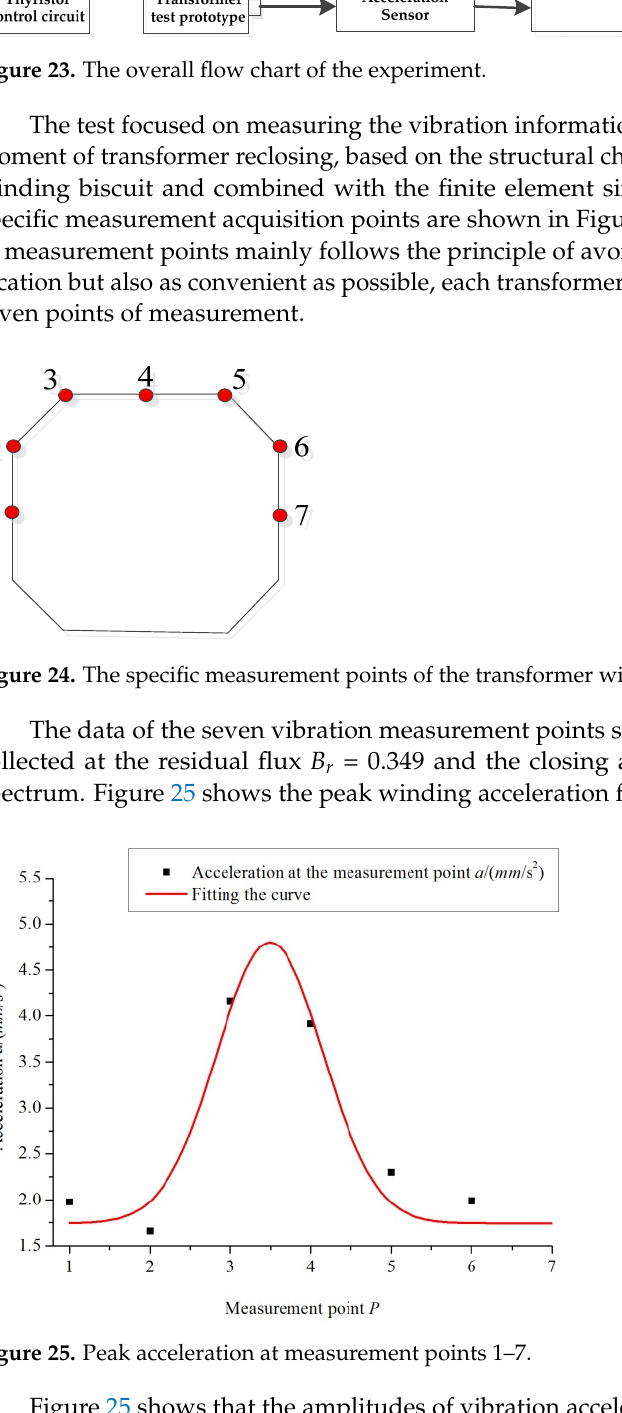
Figure 23. The overall flow chart of the experiment.